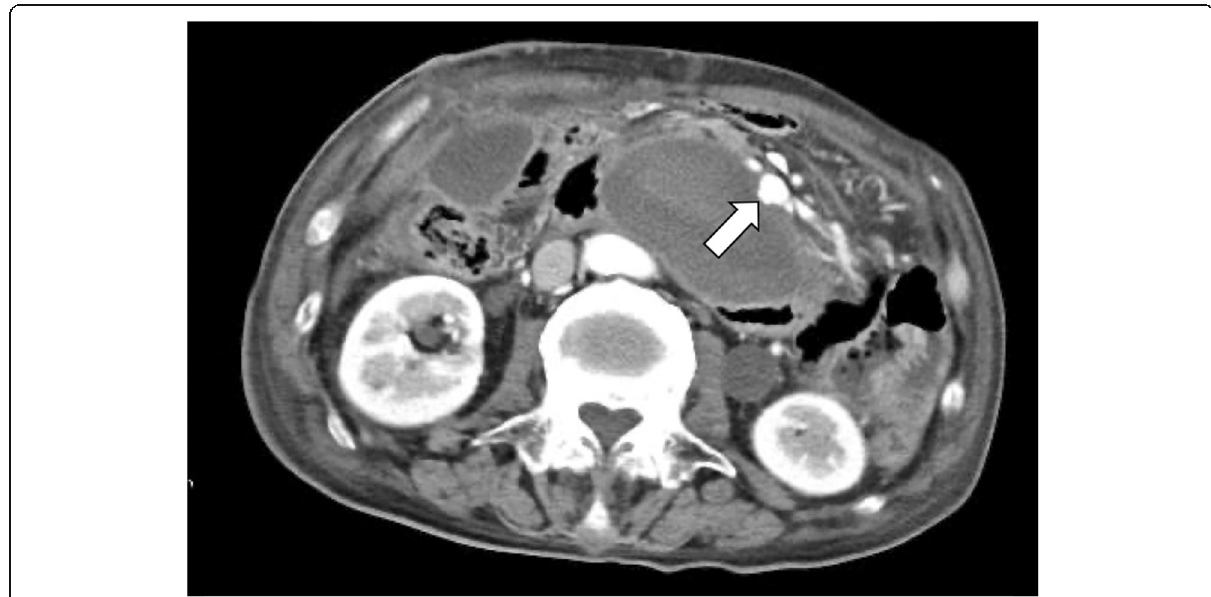
Fig. 7 Computed tomography after first vomiting showed extravasations from the untreated anterior inferior pancreaticoduodenal artery aneurysm (shown by arrowheads). An untreated anterior inferior pancreaticoduodenal artery aneurysm appeared to be rounded (13 × 11